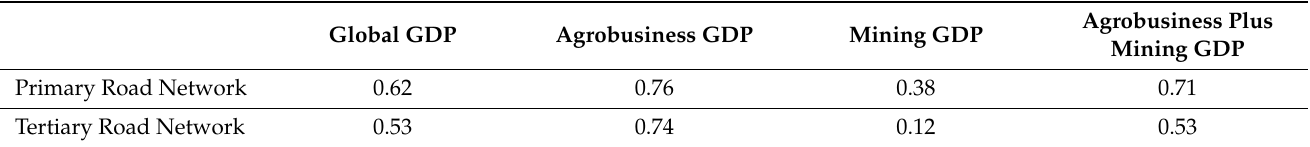
Table 9. R value upon correlating global and sector GDP with length of the primary and tertiary road network by